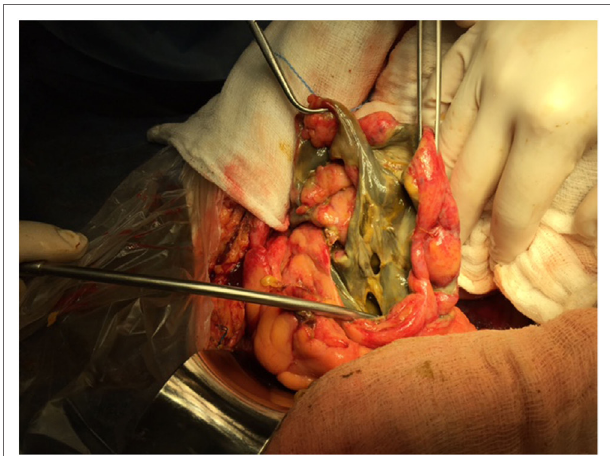
FiGURe 4 | Colon infarction due to occlusion of the IMA may have devastating results. In this case there is gangrene of part of the sigmoid colon, which caused extensive rupture of the colonic wall and feculent peritonitis. Hartmann’s procedure was performed in this case with positive